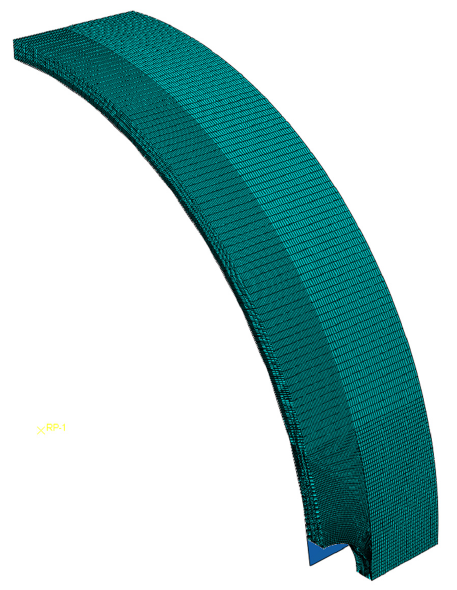
Figure 15. Overview of constraints, surface names, reference point, and the cylindrical coordinate system.